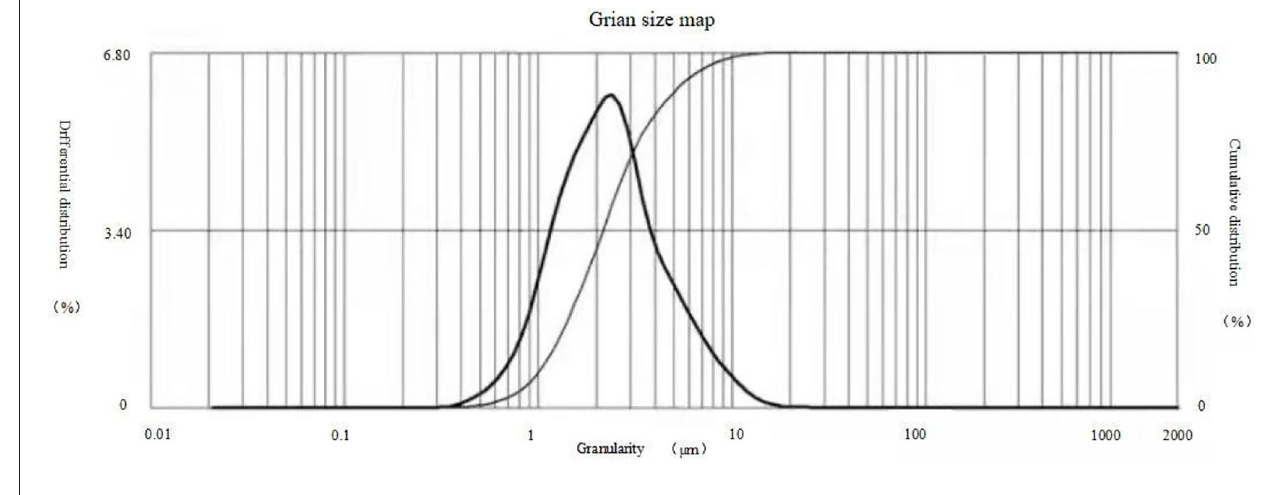
FIGURE 3 | Particle size distribution of microcapsule 1.